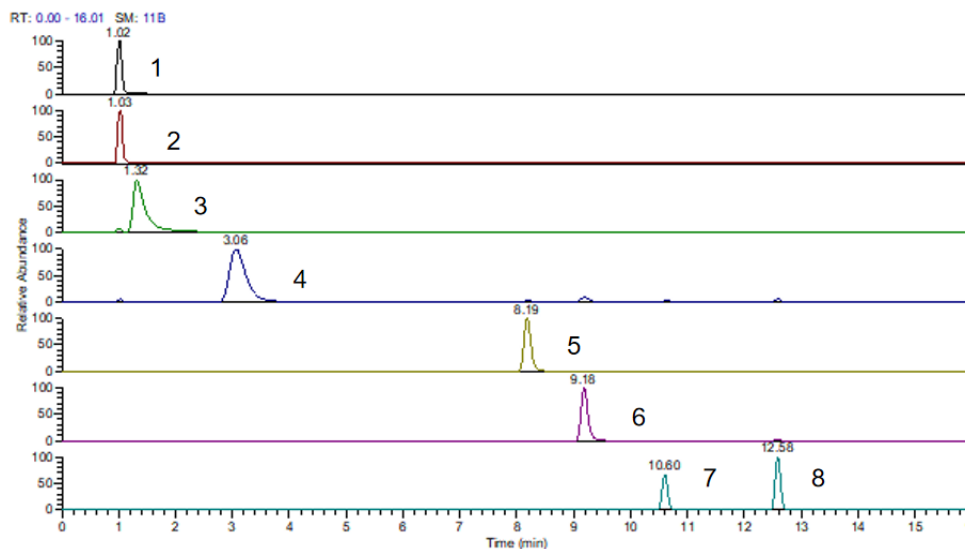
Figure 2. HPLC chromatogram of glucosinolates (GLSs) isolated from kale varieties. Peak numbers refer to the GLSs listed in Table 3. Peak no. 1,.Glucoraphanin(GRA); 2, sinigrin(SIN); 3, Gluconapin(GNA); 4, 4-Hydroxyglucobrassicin(4-HGBS); 5, Glucoerucin(GER); 6, Glucobrassicin(GBS); 7, 4-Methoxyglucobrassicin(4-MGBS); 8, Neoglucobrassincin(NGBS).